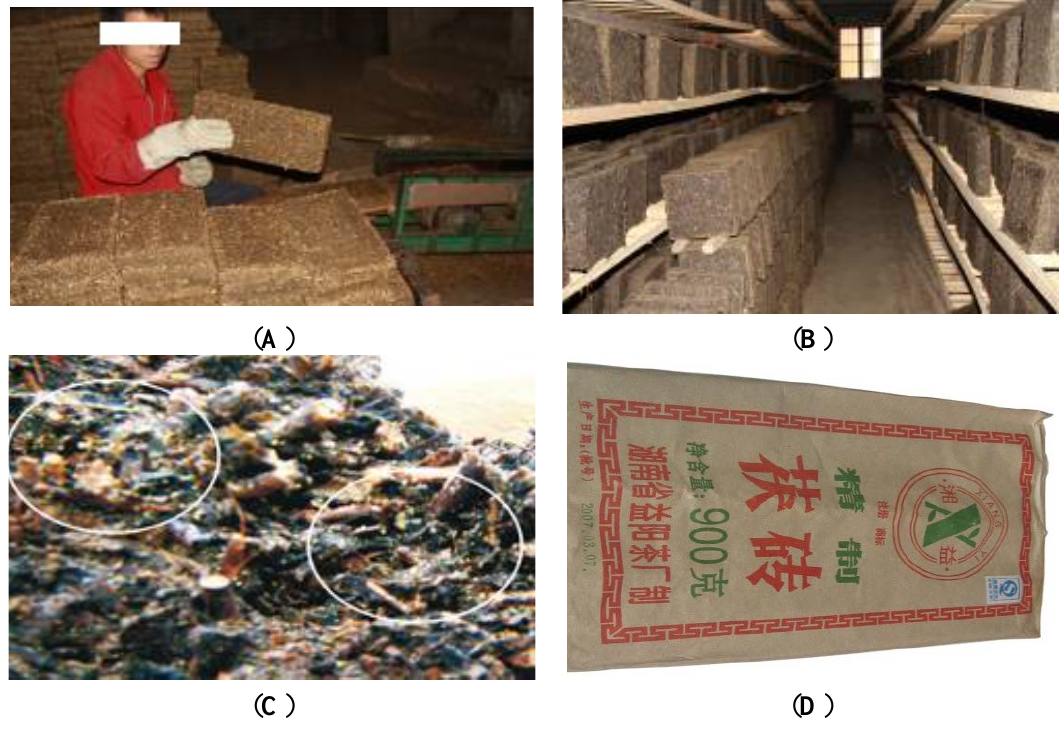
Figure 1. Preparation of Fuzhuan brick-tea. ( A ). The brick shape. ( B ). The fermentation room. ( C ). The golden flower in the fermented tea. ( D ). Packaged